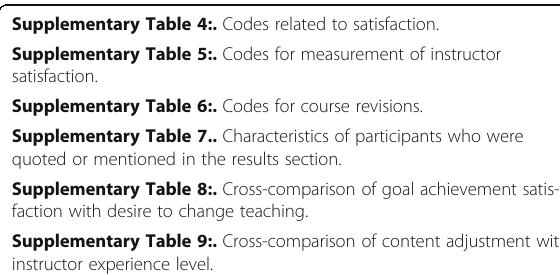
Supplementary Table 4:. Codes related to satisfaction. Supplementary Table 5:. Codes for measurement of instructor satisfaction. Supplementary Table 6:. Codes for course revisions. Supplementary Table 7.. Characteristics of participants who were quoted or mentioned in the results section. Supplementary Table 8:. Cross-comparison of goal achievement satis- faction with desire to change teaching. Supplementary Table 9:. Cross-comparison of content adjustment with instructor experience